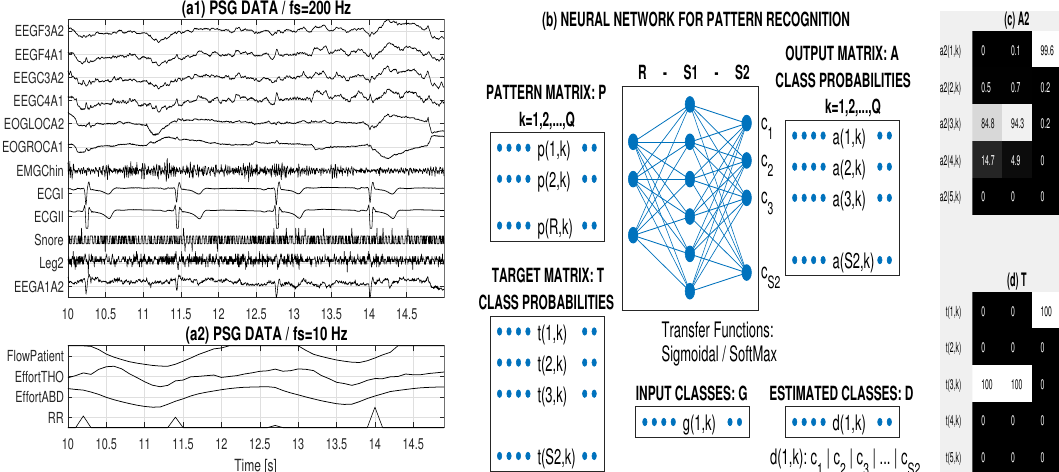
Figure 1. Principle of sleep feature classification using a two-layer neural network with sigmoidal and softmax transfer functions presenting ( a1 , a2 ) a sample record of multichannel data 5 s long recorded with the sampling frequency of 200 and 10 Hz, respectively; ( b ) neural network structure for pattern recognition estimating probabilities of individual classes and evaluating the most probable class for each column vector of input features; and ( c , d ) evaluated and target probabilities (%) of output classes for selected patterns (detail of Figure 3d and S 2 = 5).